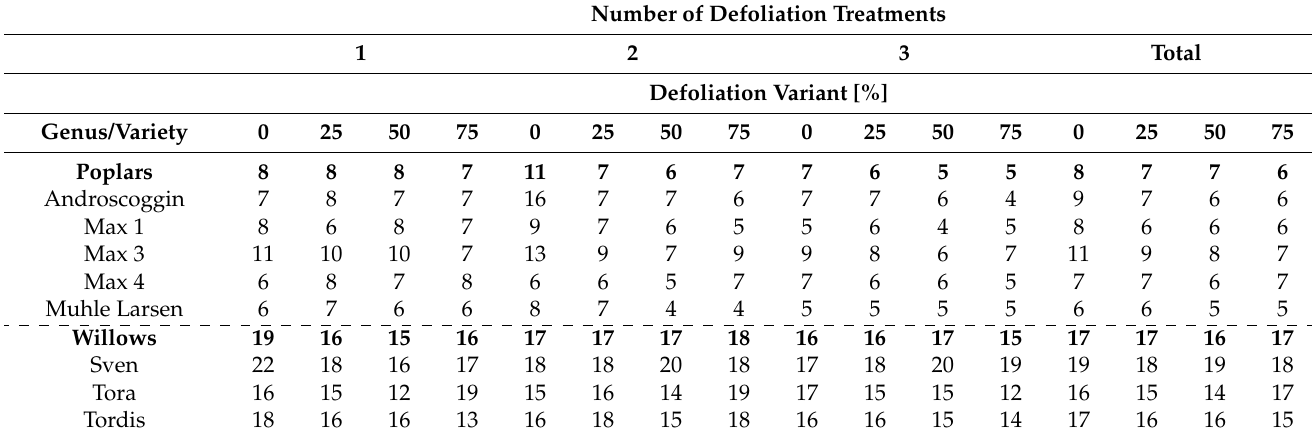
Table 6. Mean number of resprouting shoots per stool on the study site in Großthiemig with regard to the number of defoliation treatments in June 2009 after the harvest in March 2009 with regard to the defoliation variant in 2007 and 2008.